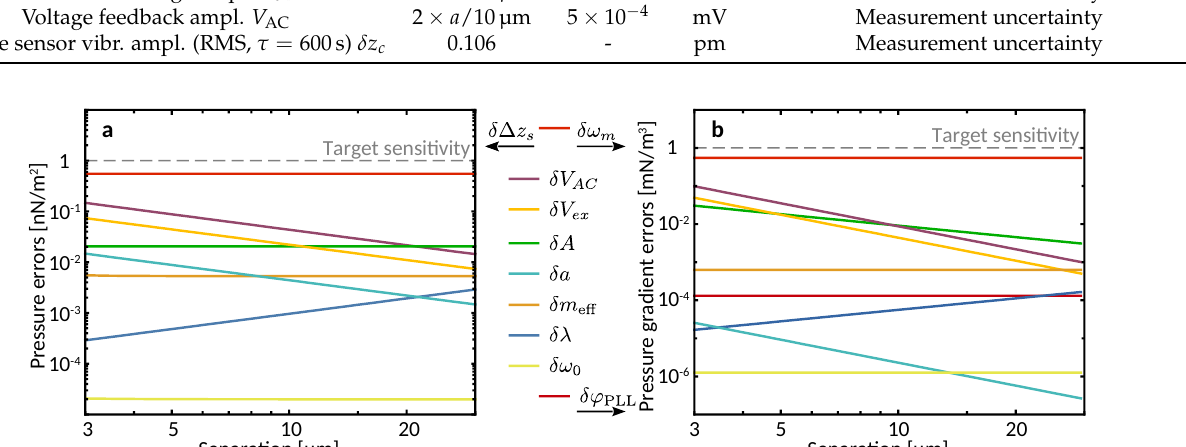
Figure 7. Contributions of the different parameter errors to the detection errors δ P det ( a ) and δ P (cid:48) contributions below the vertical scales